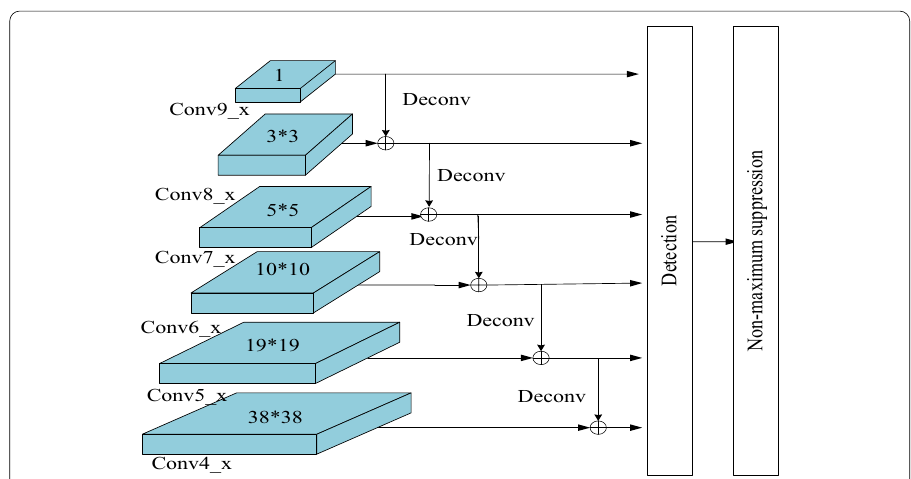
Fig.5 Feature pyramid network structure